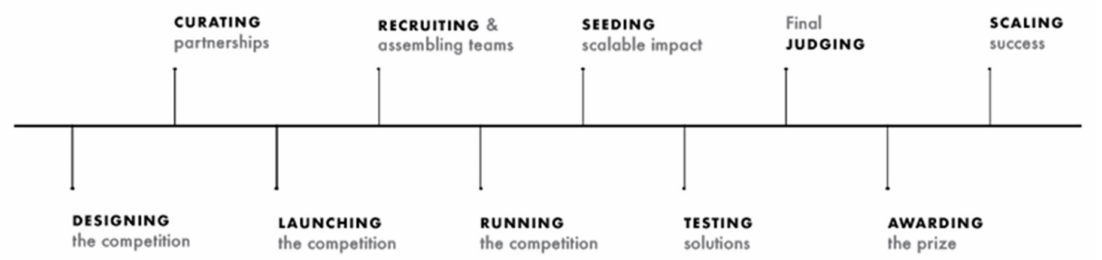
Figure 1. Typical lifecycle of an XPRIZE